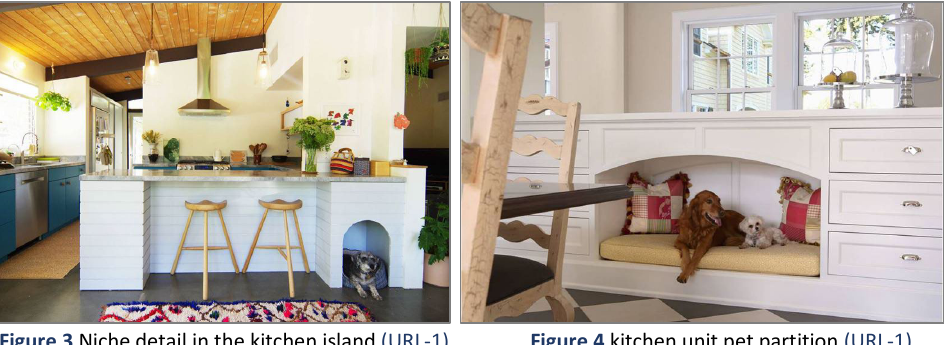
Figure 3 Niche detail in the kitchen island (URL-1) Figure 4 kitchen unit pet partition (URL-1)